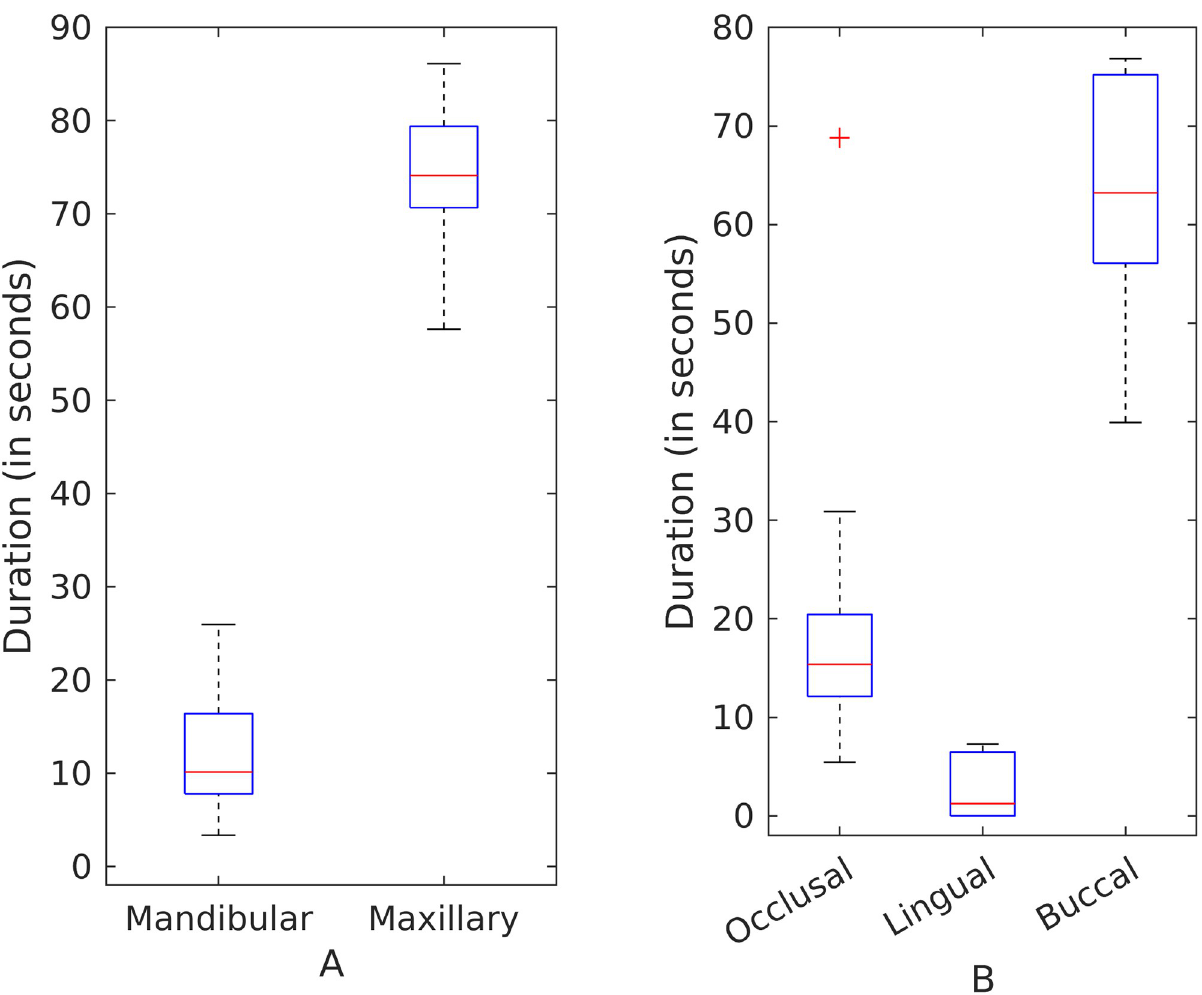
Fig 5. Between-individual variability in brushing duration by region. (A) by jaw and (B) by tooth